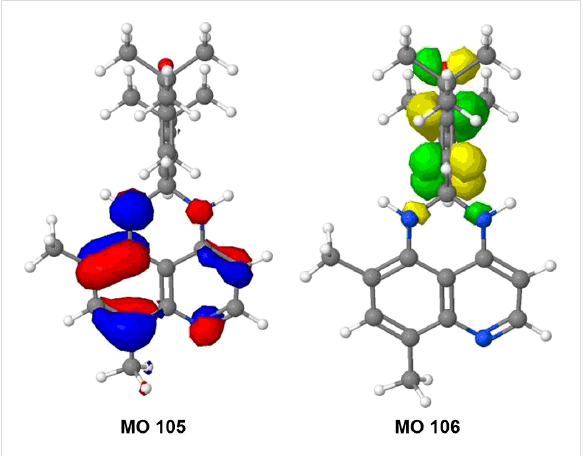
Figure 6: HOMO (MO 105, red and blue) and LUMO (MO 106, green and yellow) computed for 3a in its ground (S 0 ) state. Similar results were observed for the frontier orbitals of 1b and 3b (see Supporting Information File